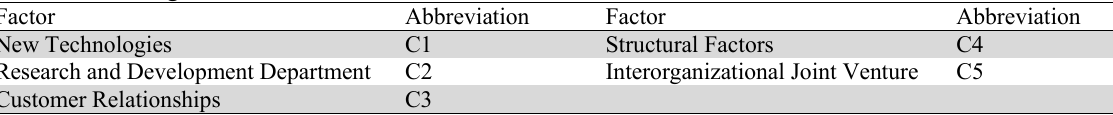
Factors Affecting Innovation